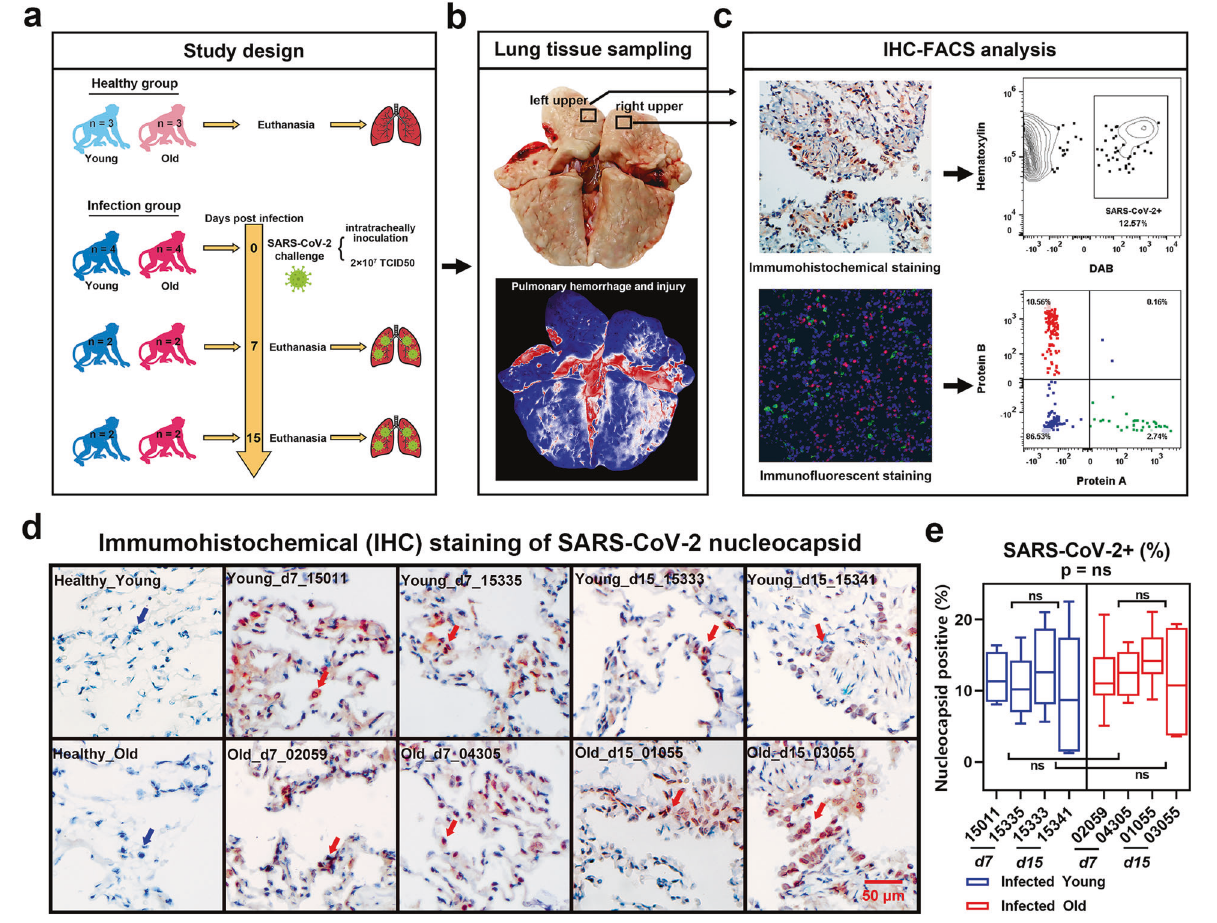
Fig. 1 Pathological analysis of lung tissues from SARS-CoV-2-infected young and old RMs. a Flow chart showing the grouping of experimental animals and strategy of sample collection. After the intratracheal challenge, four young and four old RMs were killed (half on day 7 and a half on day 15) for lung dissection. Lungs of three healthy young and three healthy old RMs were used as controls. b Pseudo-color images (bottom) showing hemorrhage and injury sites (red) and non-obvious lesions (blue) in the lungs. FFPE tissue sections were taken from non- obvious lesions of the upper left and right lungs (top). c Microscopy images (left) showing viruses labeled by IHC and proteins labeled by mIF. Two-dimensional scatter diagram (right) showing process of converting microscopy images into fl ow cytometry data for quantitative analysis using IHC-FACS. d Detection of SARS-CoV-2 nucleocapsid antigens by IHC in FFPE sections of healthy and infected RMs. Nuclei indicated by blue arrows are stained dark blue (hematoxylin). Nucleocapsid indicated by the red arrow is stained dark red (DAB). e Box plot showing a comparison of SARS-CoV-2 + cell rate in lung tissue sections of young and old RMs. Data calculated by 10 DAB staining images from each animal ’ s lung tissue sections are shown as median with min to max. P value at top of the fi gure is a comparison of all animals in young and old groups. Square brackets in the fi gure are comparisons between two groups of animals at different time points. p > 0.05 indicates no statistical difference